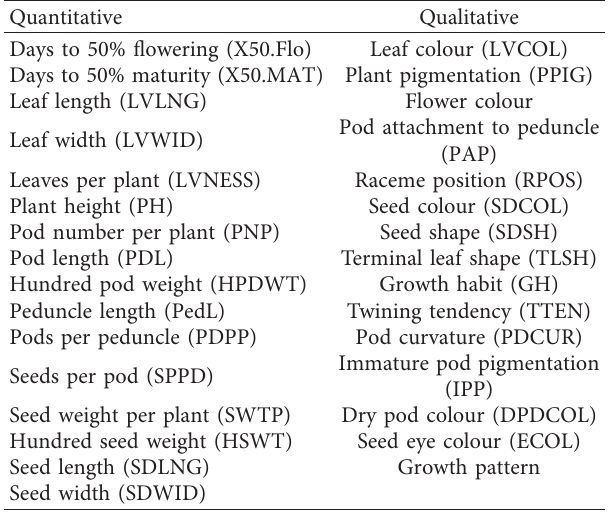
Table 2: Traits of cowpea assessed during the study based on the IBPGR cowpea